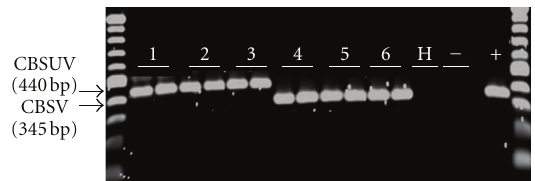
Figure 3: RT-PCR amplification of CBSUV and CBSV genomes using newly designed primers (CBSVF2 in combination with CBSVR7 and CBSVR8). 1 = CBSUV-[UG:Kab4-3:07], 2 = CBSUV- [TZ:Kib10-2:03], 3 = CBSUV-[KE:Mwa16-2:08], 4 = CBSV- [TZ:Zan6-2:08], 5 = CBSV-[MZ:Nam1-1:07], 6 = CBSV-[TZ:Nal3- 1:07], H = RNA extraction from a CBSD-free plant, − = negative water control, and + = a known CBSV RNA control from previous sample preparations. The size ladder at each border of the gel is the 100 bp molecular weight markers (New England Biolabs,